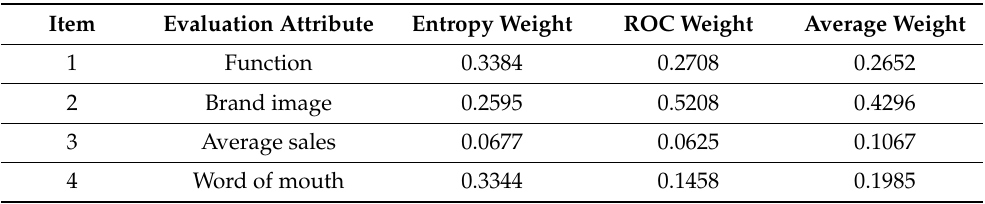
Table 11. The attribute weights.